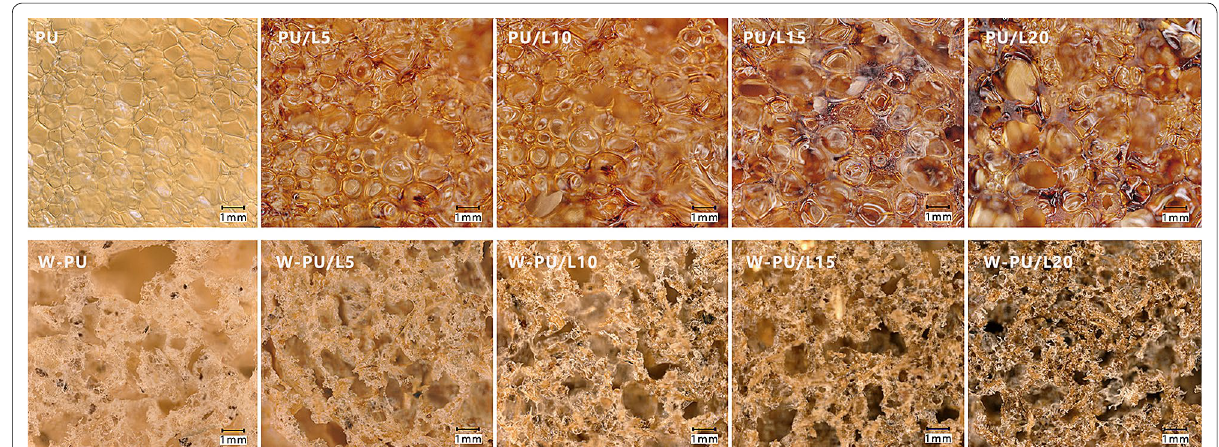
Fig. 4 Morphology of cross section of the PU and W–PU foams containing varying contents of lignin observed perpendicular to foam rise